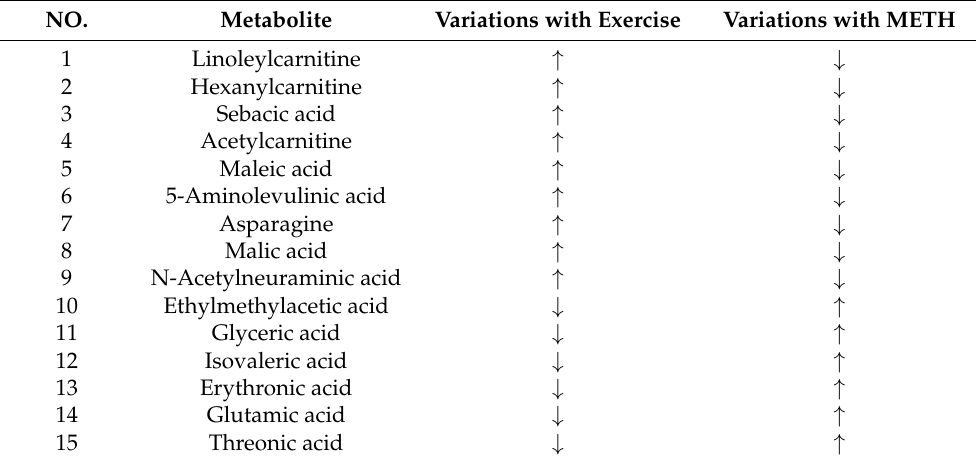
Table 3. Metabolites with different trends under exercise and METH.